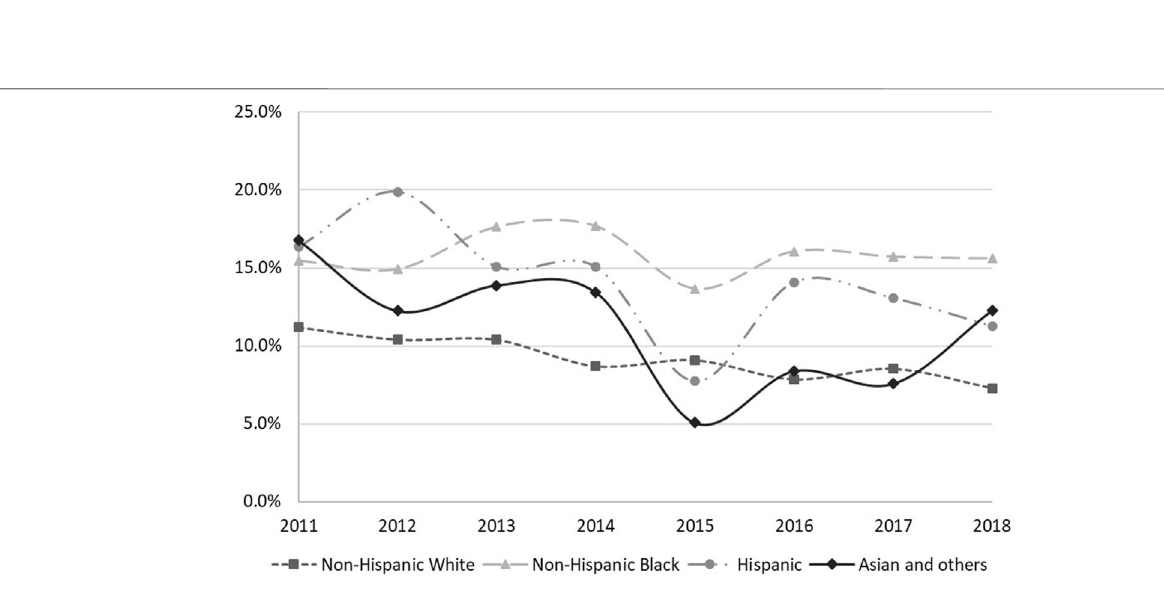
Frontiers in Pharmacology |